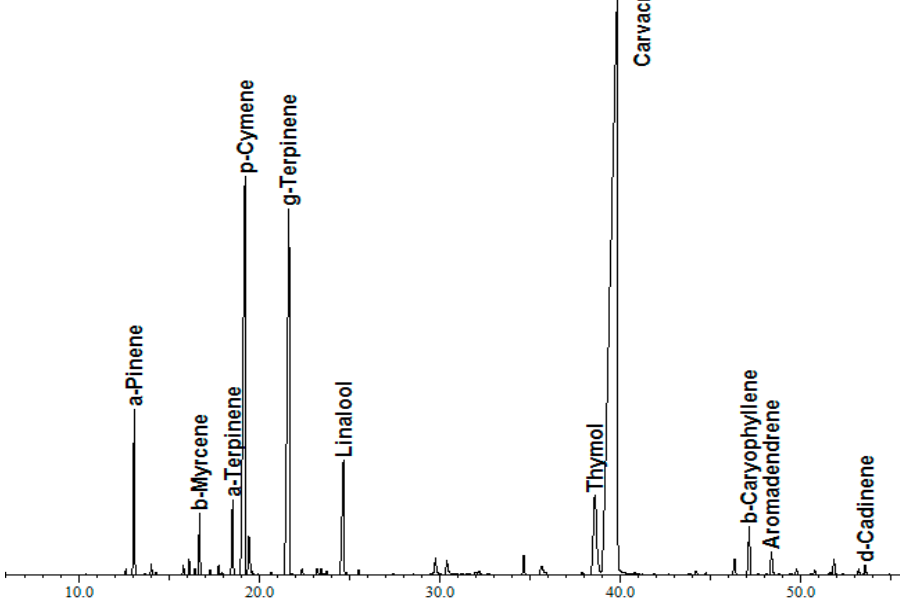
Figure 1. Part of the chromatograph of thyme essential oil analyzed with Gas Chromatography-Mass Spectrometry. ( X -axis in minutes).